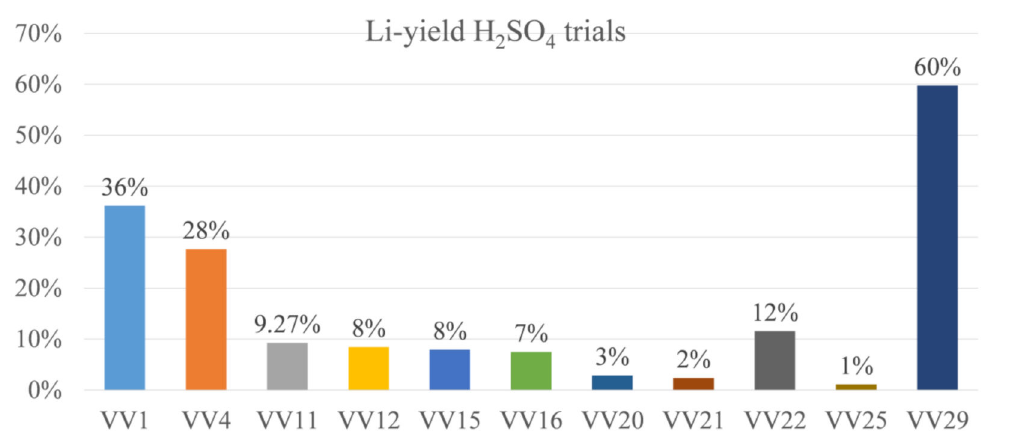
Figure 8. Overview on the lithium yields reached in the pre-trials by using H 2 SO 4 as solvent. “VV29” di ff ers from the other H 2 SO 4 -trials in terms of the pH additive used: in this case, KOH was used. In the other H 2 SO 4 -trials, lithium losses can be asserted to high contents either in the C filter